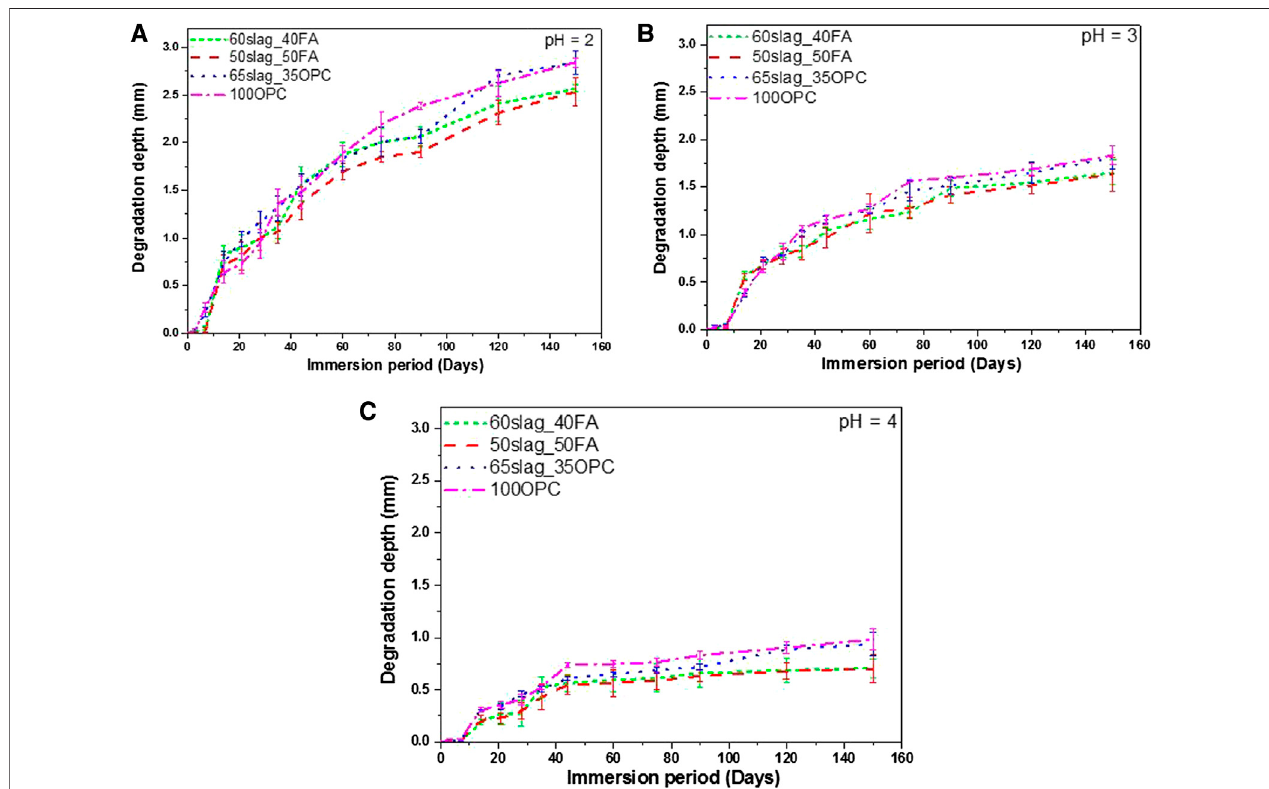
FIGURE 7 | Total degradation depth evolution over 150-day immersion period for the four mortar mixes exposed phosphoric acid with (A) pH = 2; (B) pH = 3; and (C) pH =